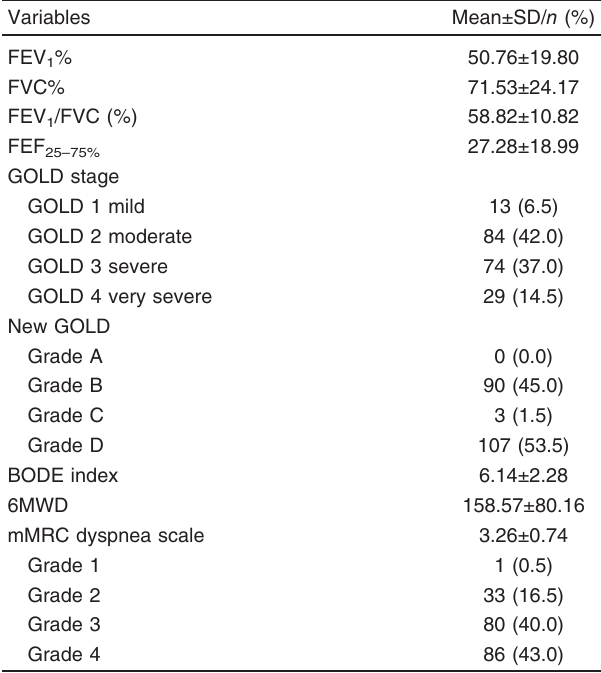
Table 2 Spirometric indices, BODE index and its parameters and St George ’ s Respiratory Questionnaire score for the studied population ( n = 200)